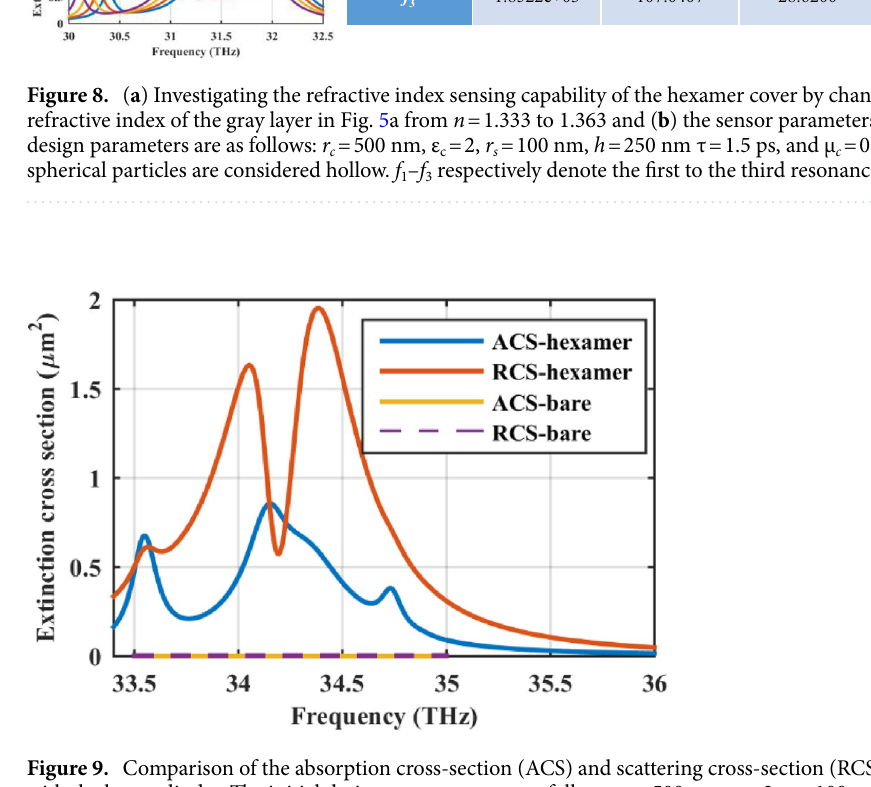
Figure 9. Comparison of the absorption cross-section (ACS) and scattering cross-section (RCS) of the hexamer with the bare cylinder. The initial design parameters are as follows: r c = 500 nm, ε c = 2, r s = 100 nm, h = 250 nm, τ = 1.5 ps, and μ c = 0.5 eV. The spherical particles are considered